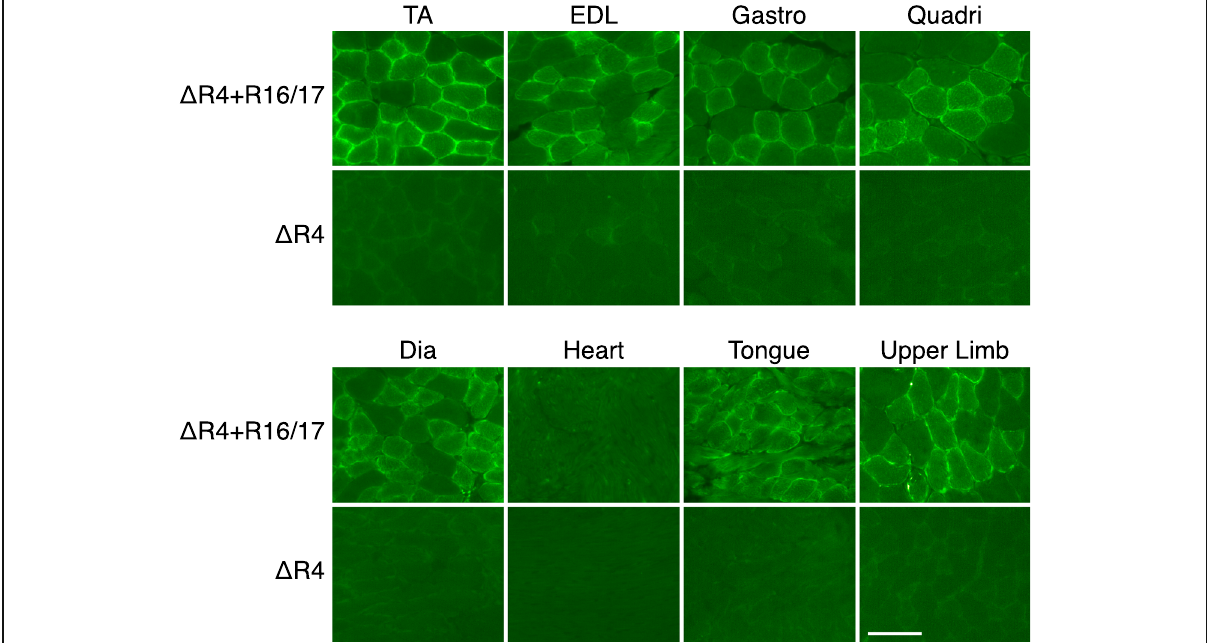
Fig. 3 Body-wide distribution of mTAT.R16/17.GFP.Pal protein in Δ R4 mouse muscles. The mTAT.R16/17.GFP.Pal protein was systemically delivered to Δ R4 mice by IP and IV injections. The distribution of mTAT.R16/17.GFP.Pal protein in muscles was evaluated by GFP signal. As shown here, the GFP signal in skeletal muscles, including the TA, EDL, Gastro, Quadri, Dia, Tongue and upper limb muscles, was higher than in the heart. TA: tibialis anterior; EDL: extensor digitorum longus; Gastro: gastrocnemius; Quadri: quadriceps; Dia: diaphragm. Scale bar = 50 μ